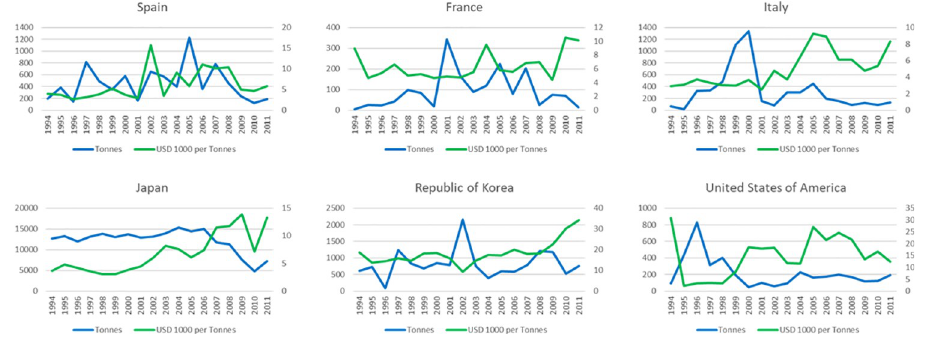
Fig 5. Time series evolution. Source: Own elaboration based on